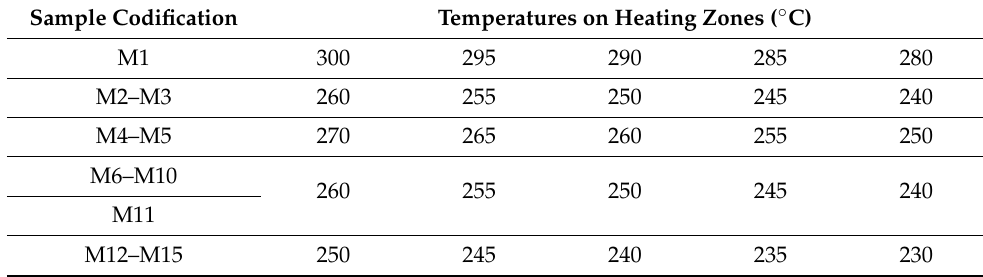
Table 2. Processing temperature